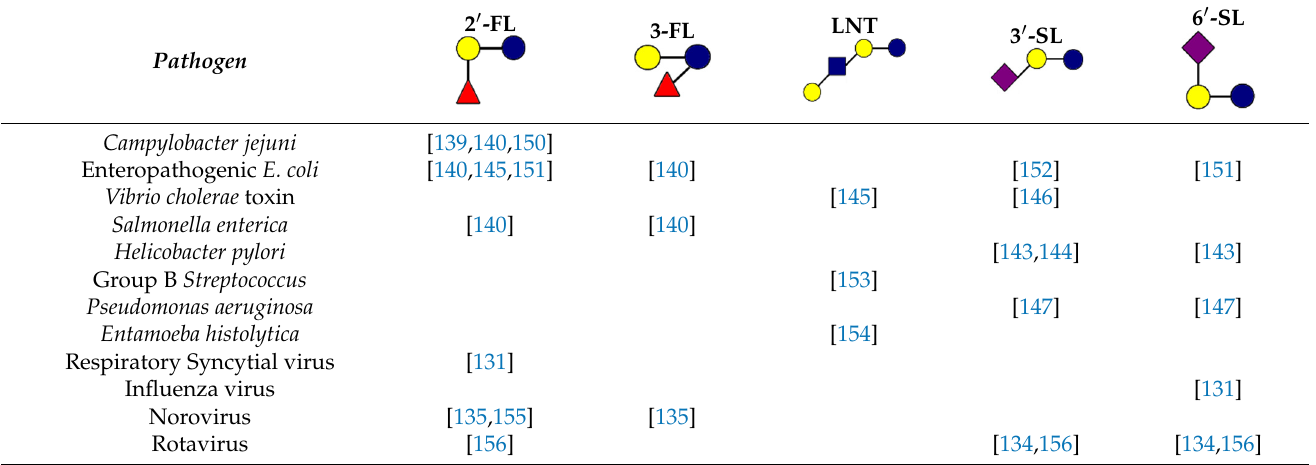
Table 1. Summary of primary research manuscripts demonstrating that specific HMOs inhibit pathogen adhesion to host cells. Individual HMO structures exhibit distinct pathogen-binding specificity; this suggests that multiple diverse HMO structures expand the cumulative profile of anti-adhesive activity in milk. HMO, human milk oligosaccharides.